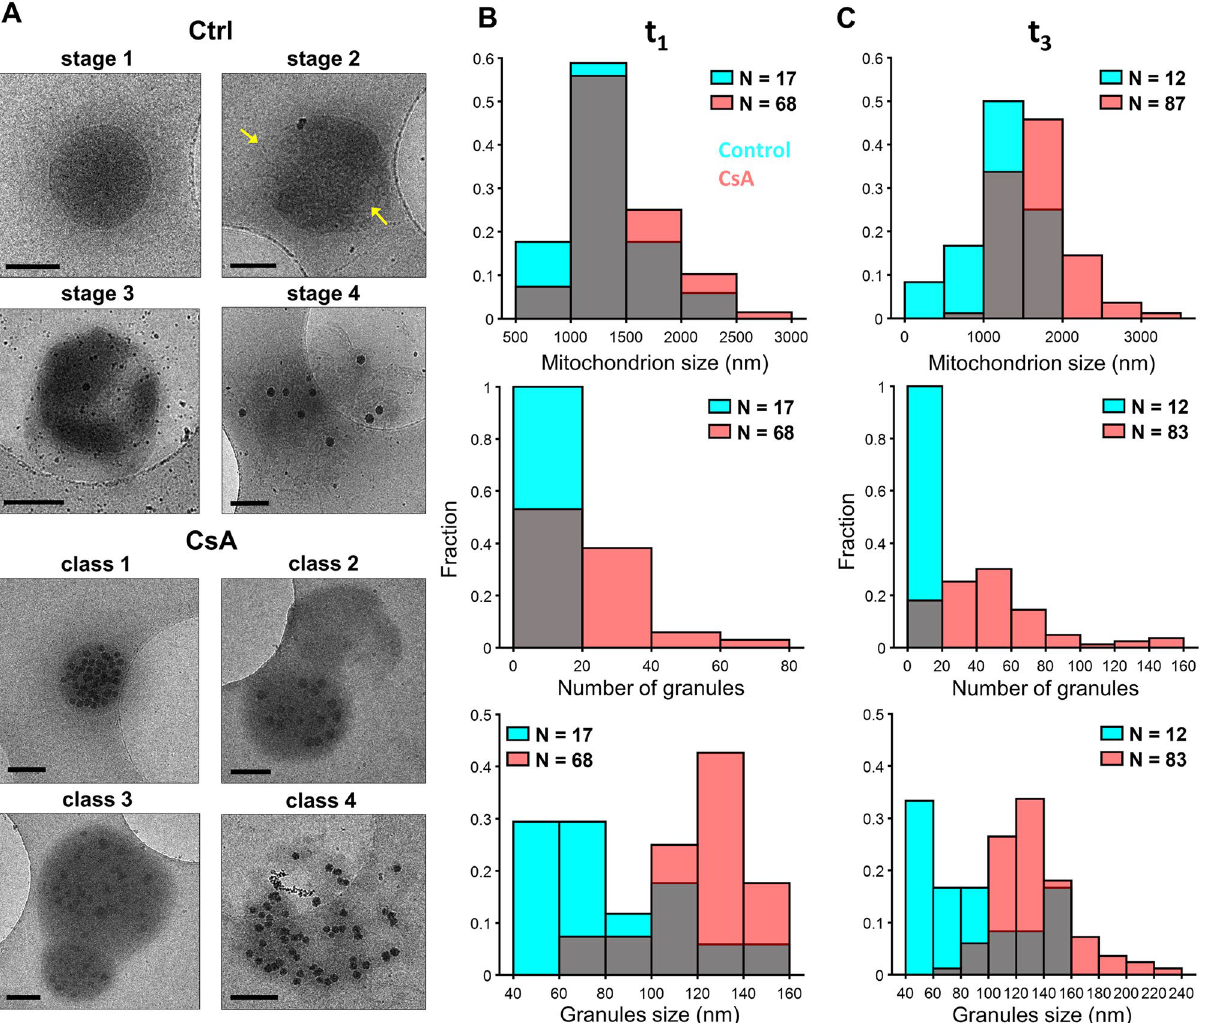
Figure 6. In extreme calcium overload conditions, CsA preserves inner mitochondrial membrane intactness. Representative images before the addition of a 100 µM calcium bolus in the presence or absence of 1 µM CsA. ( A ) The addition of 100 µM calcium led to the formation of granules of various sizes varying between but not within mitochondrion. This large bolus of calcium induces membrane rupture in control mitochondria in multiple location as shown by the arrows. However, mitochondria treated with CsA were protected. ( B ) There are no differences in the average mitochondrial size just after calcium addition between control and CsA-treated mitochondria, but the CsA-treated mitochondria had larger and more abundant granules. ( C ) At 10 min after the addition of calcium, all three measures (mitochondrial size, granule size, granule number) become larger in the CsA-treated mitochondria. In contrast, all three measures decreased in control mitochondria due to membrane fragmentation and evisceration. The number of images analyzed by the time point for control and CsA treated conditions is given by n. Scale bars are 250 nm. Gray zones represent the overlapping points between this 66,73 . A recent study by Wescott et al. found that physiological cytosolic calcium transients cause a gradual, step-wise increase in matrix calcium concentration per beat rather than large transient peaks 8 . They also showed that at high pacing rates, the matrix calcium concentration did not change any further. Further studies are required to determine whether these results are due to equal influx and efflux of calcium per cycle or due to calcium buffering. At this point, it is possible that calcium buffering in the form of calcium phosphate granule formation becomes relevant. In a separate study, calcium phosphate granules were observed in the matrix near cristae junctions in a variety of different eukaryotic cells under physiological conditions 48 . Given the relevance In Fig. 8, we present a model that accounts for various characteristics of membrane fragmentation before the MPT onset. This model integrates findings from our cryo-EM analysis with mitochondrial function and reca- pitulates the effects of calcium on the mitochondrial structure. Based on our findings, we believe that changes in